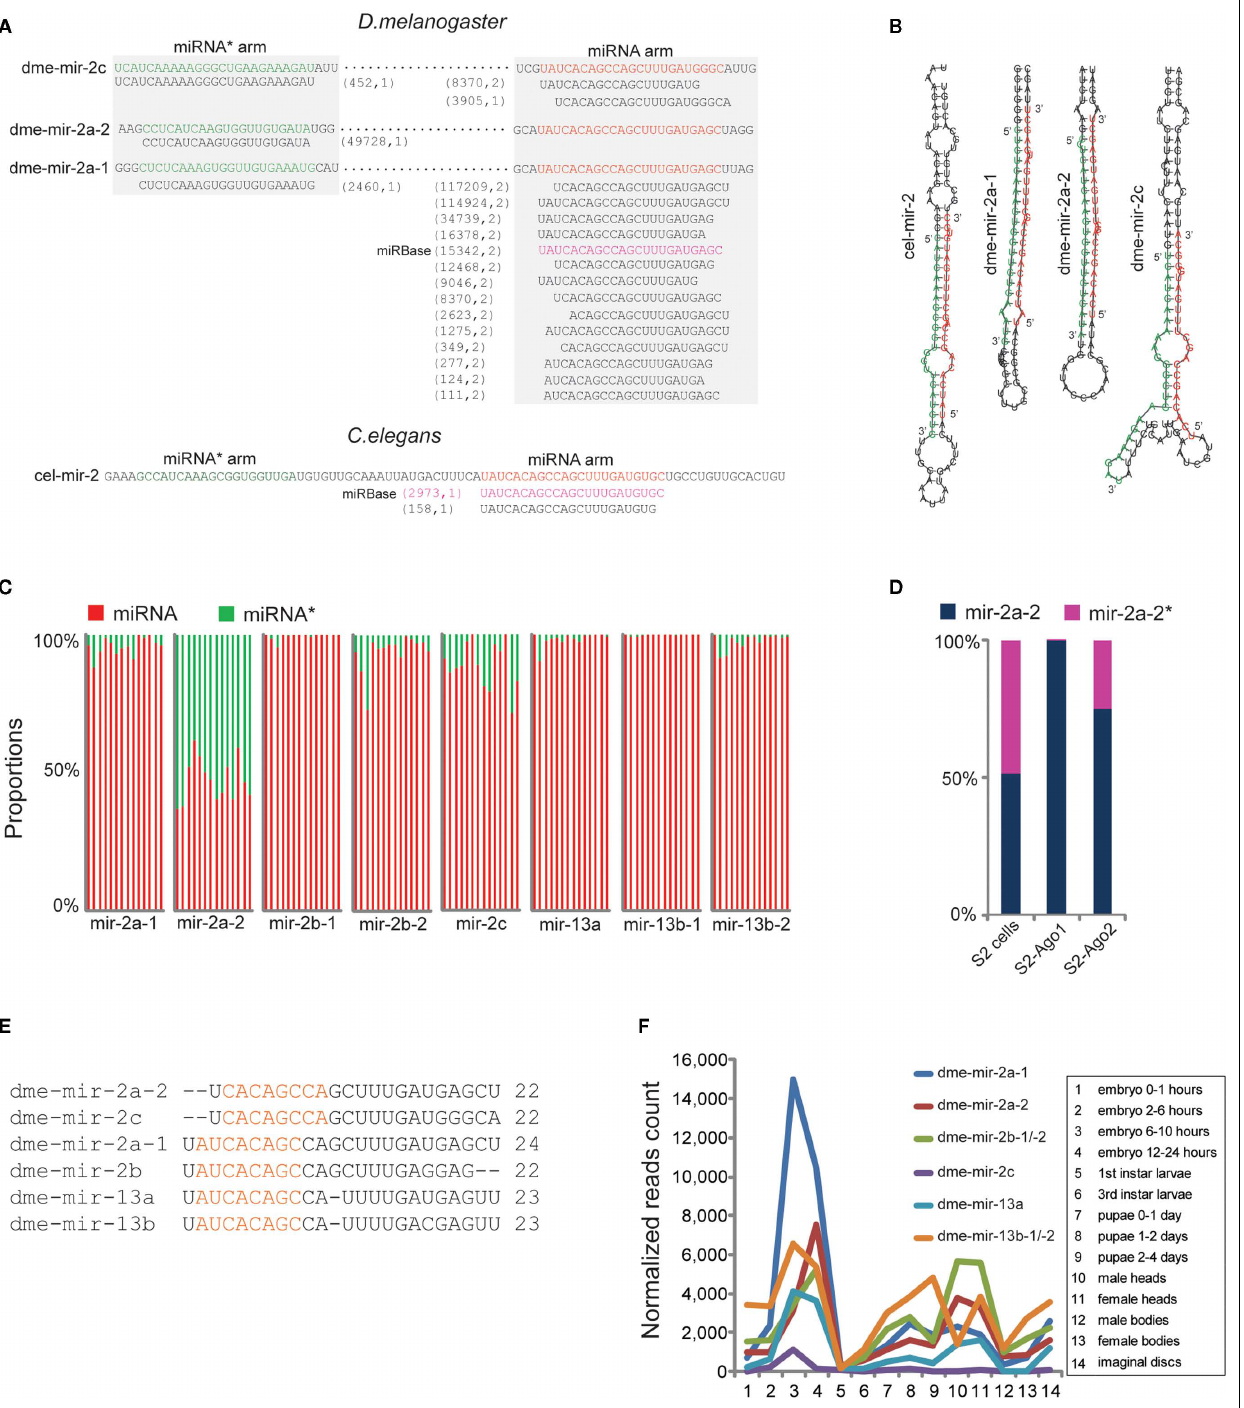
duplexes with 2-nt overhang at 3 (cid:2) ends. (C) The proportions of the corrected miRNA and miRNA ∗ strands for each miR-2 member across 14 samples. Each column represents one sample.The mir-2a-2 is the only exception that have equal amount of miRNA and miRNA ∗ strands across all the samples. (D) Even mir-2a-2 and mir-2a-2 ∗ both existed in S2 cells, only the guide strands were associated with Ago proteins. (E) The alignment of corrected miR-2 family members. (F) The rebuilt developmental expression profile of D. melanogaster miR-2 family using the corrected miR-2 family